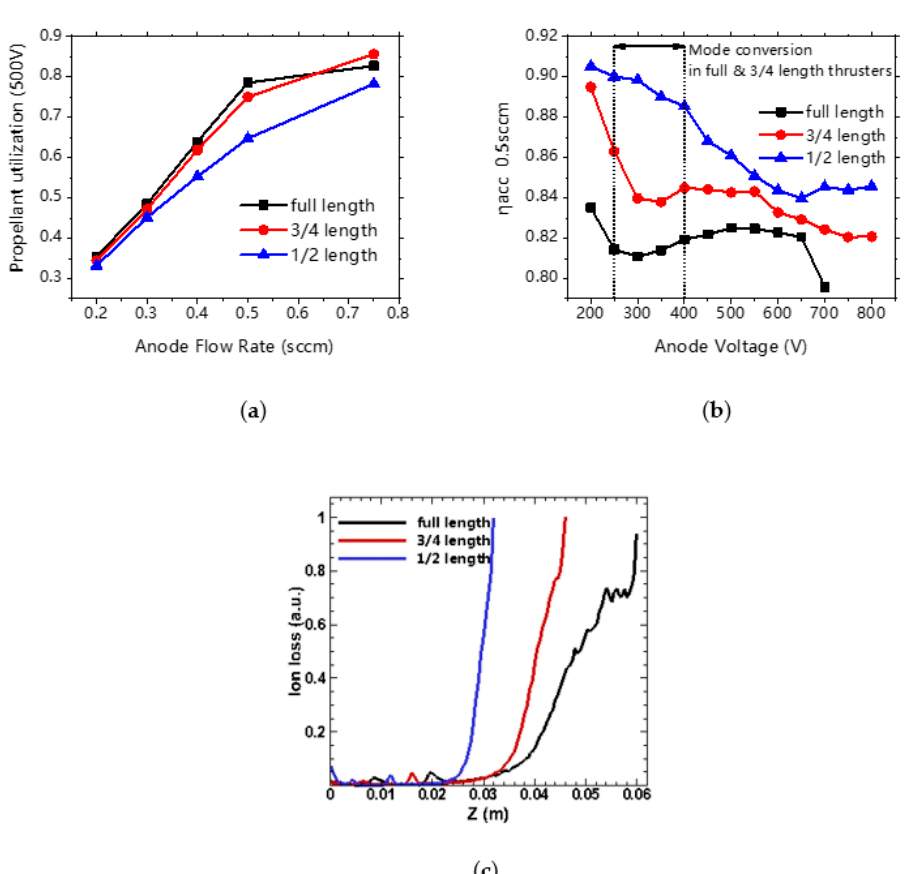
Figure 16. Differences among thrusters with different channel lengths: ( a ) propellant consumption and ( b ) ion acceleration efficiency. In ( c ), the results of the simulation of ion loss on channel walls for different channel lengths are presented.